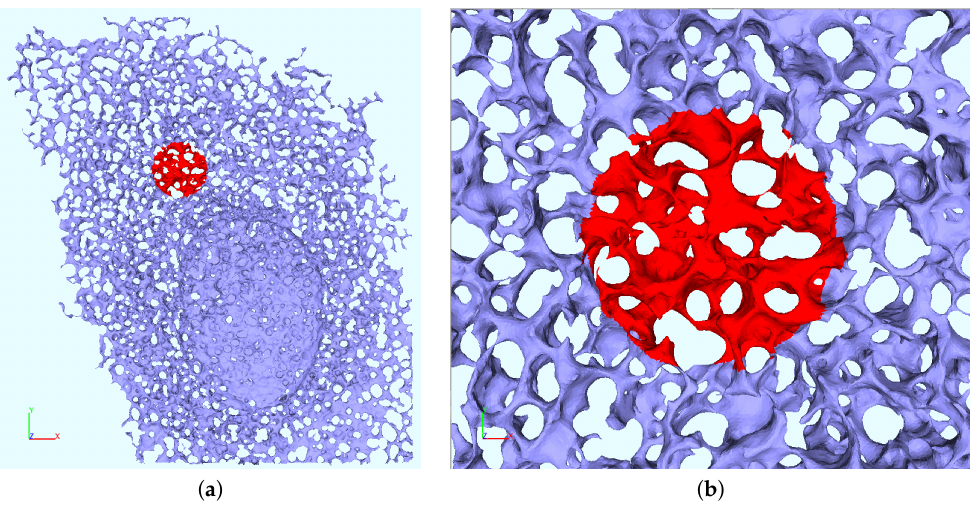
Figure 3. Surface mesh of reconstructed ER geometry E 1 . ( a ) Computational domain used for the simulations of the FRAP experiments of NS5A on (intra)cellular level. Dark blue: unbleached region U , Red: FRAP region F used for bleaching (covering a surface of 38 µ m 2 in the 2D projection plane as in experiment); cf. Sections 2.1 and 2.6. ( b ) Magnification around FRAP ROI F